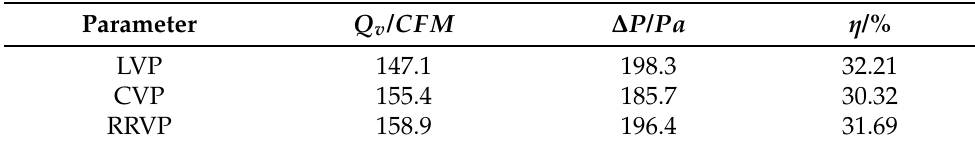
Figure 9. Shape comparison of different volute profiles’ design. Table 4. Comparison of the fan aerodynamic performance of different volutes under maximum flow working